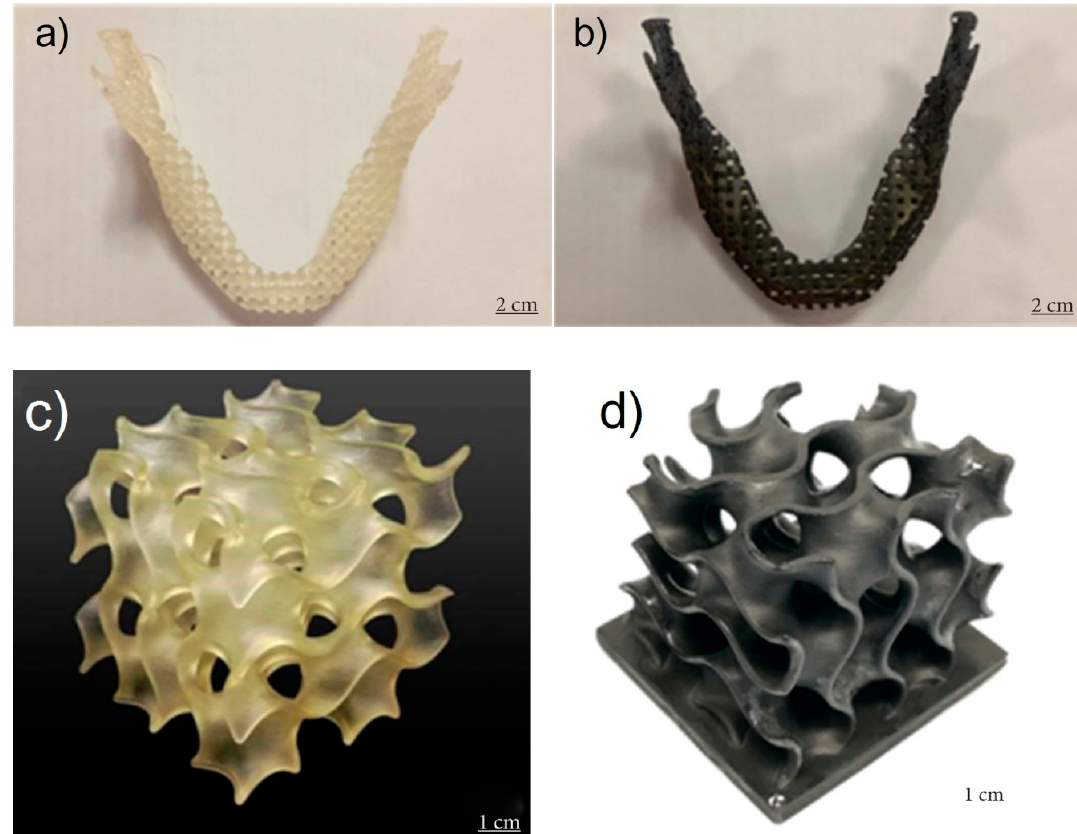
Figure 7. Pictures of ( a , c ) monolithic UV-cured resin and ( b , d ) graphene-reinforced nanocomposite jawbone with a square architecture and gyroid scaffold for bone tissue engineering, respectively. Reproduced from [172], with permission from Zuying Feng et al., 2019.